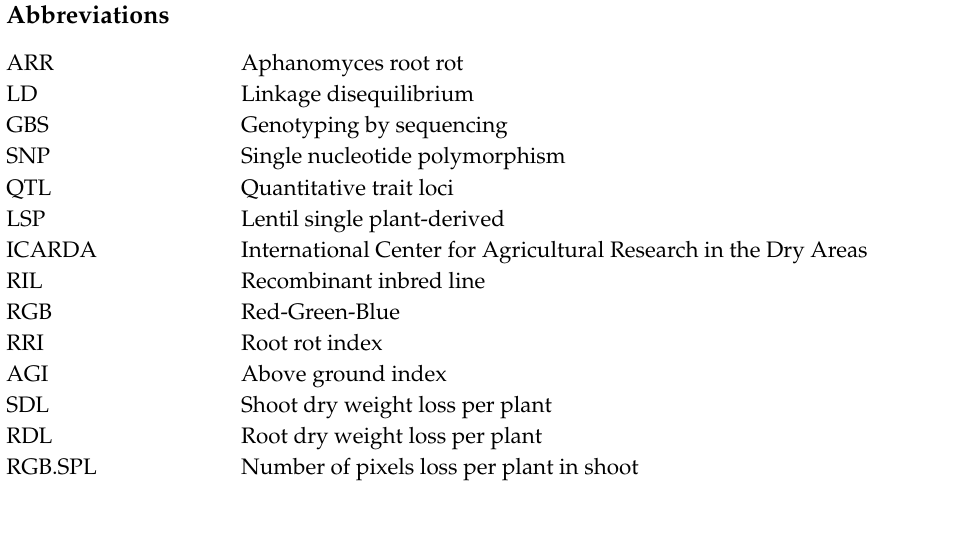
s1. Figure S1. Frequency distribution of ARR resistance traits in the RIL population and the association mapping population; Figure S2. Linkage disequilibrium decay in the association mapping population; Table S1. Summary of raw sequencing data for the RIL population and the association mapping population; Table S2. Distribution of SNPs on a linkage map for the RIL population; Table S3. Description of LD block haplotypes in the association mapping population; Table S4. LD block haplotype distribution of the association mapping population; Table S5. Putative annotation of SNPs in detected LD blocks; Table S6. Description of the association population; Table S7. Primers used for qRT-PCR in this